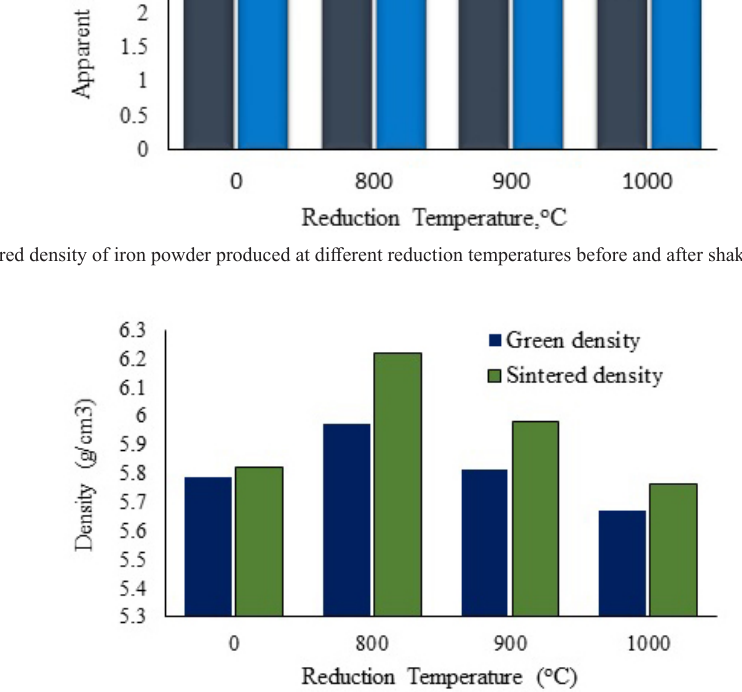
Figure 14. Measured green and sintered densities of the compacted iron powder produced at different reduction temperatures before and after sintering at 1000 o C,